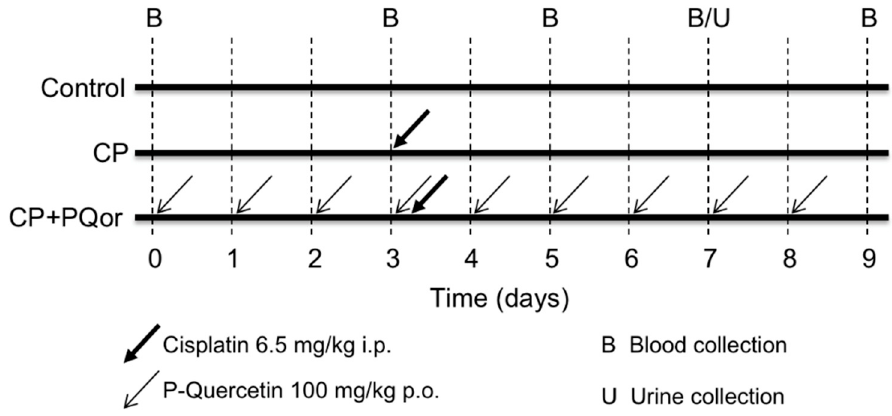
Figure 9. Scheme of the nephrotoxicity model. CP: cisplatin (6.5 mg/kg, i.p.) on day 3; CP+PQor: P- quercetin (100 mg/kg, p.o.) for 9 days and cisplatin (6.5 mg/kg, i.p.) on day